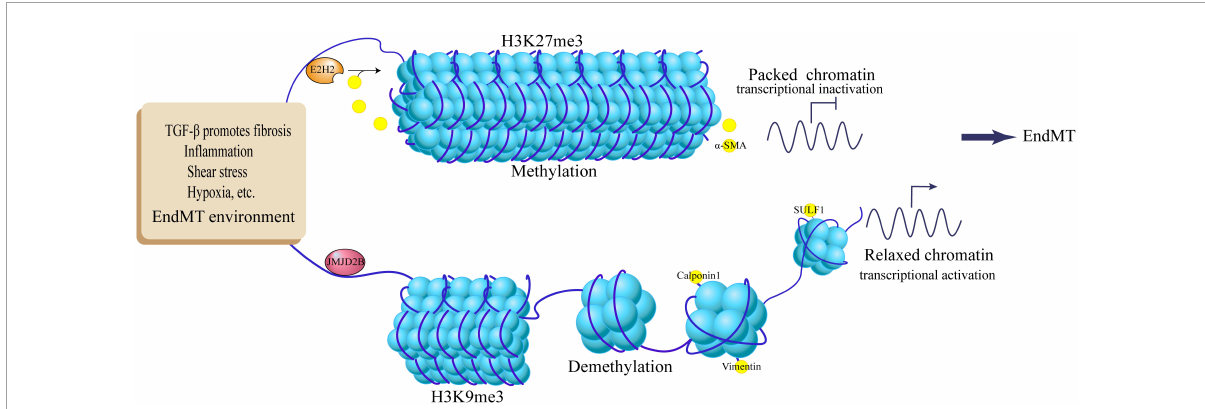
FIGURE2 Regulation of EndMT by histone methylation and demethylation. TGF- β promotes fibrosis, inflammation, shear stress, hypoxia and other EndMT environments, up-regulates JMJD2B expression, demethylates histone H3K9me3, activates target genes Calpoin1, Vimentin, SULF1, and promotes EndMT process; EndMT stimulators activate E2H2, methylate histone H3K27me3, inhibit the expression of target gene α -SMA, and inhibit the EndMT process.